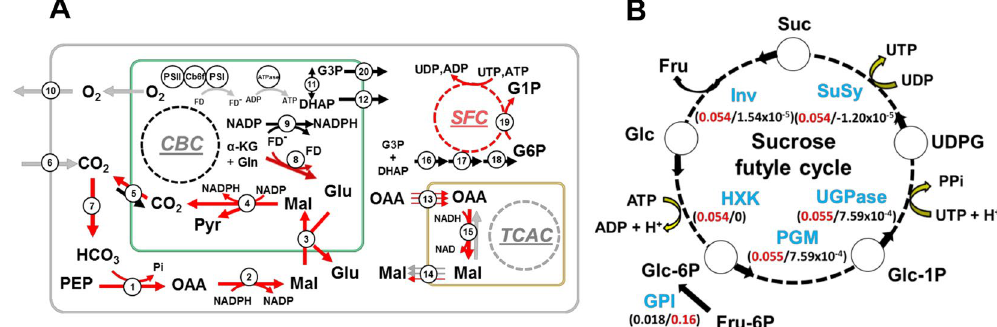
Figure 1. ( A ) A comparison of the predicted metabolic state of G and M cells and ( B ) detailed depiction of the sucrose futile cycle (SFC) predicted to take place in G cells. ( A ) Reactions colored in red (resp. black) carry significantly larger mean flux values in G (resp. M) cells. Reactions depicted in gray cannot be discriminated in terms of mean flux values between the two cell types. The numbers on the reactions correspond to the indices in Supplementary Table S1. The abbreviations used in this figure correspond to: PEP, Phosphoenolpyruvate, Pyr, Pyruvate, Mal, Malate, OAA, Oxaloacetate, Glu, Glutamate, Gln, Glutamine, α – KG, α – Ketoglutarate, FD, Ferredoxin, FD − , reduced Ferredoxin, DHAP, Dihydroxyacetone phosphate, G3P, Glyceraldehyde 3-phosphate, G1P, Glucose 1-phosphate, G6P, Glucose 6-phosphate. ( B ) This cycle is composed by five reactions in which sucrose is preferentially degraded into glucose and fructose by the activity of invertase (Inv,